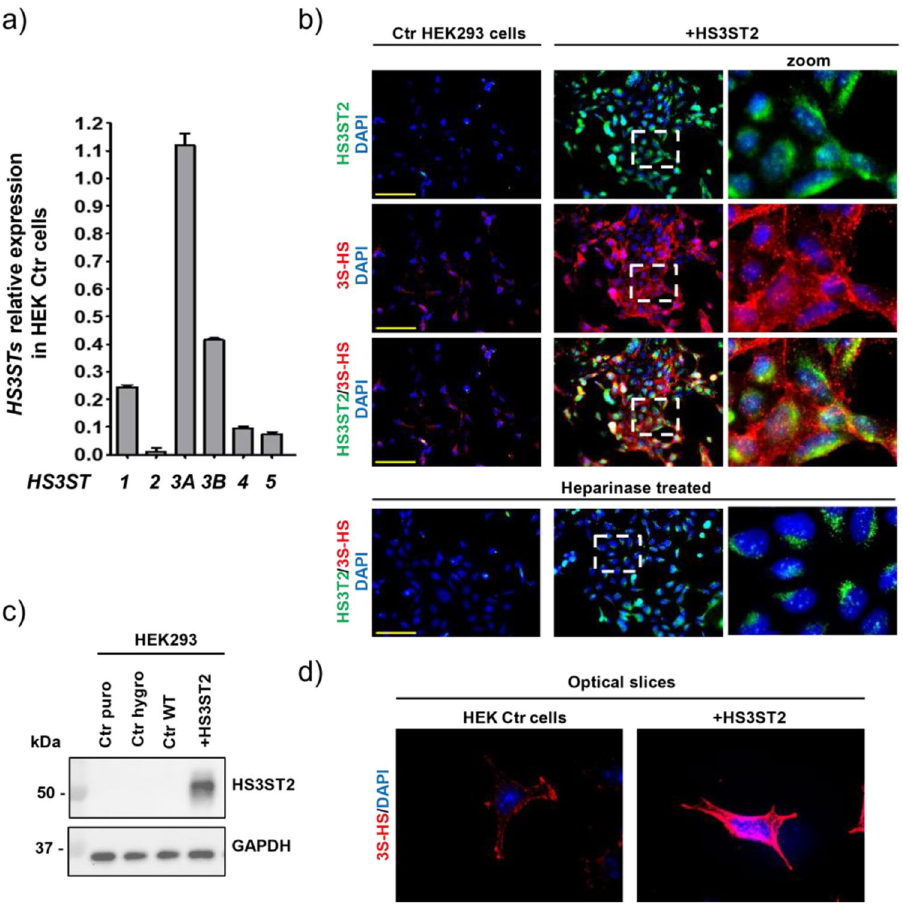
Figure 1. HEK293 expressing HS3ST2 cells produce 3S-HS. ( a ) Expression of different HS3STs in wild type (WT) HEK293 cells (HEK Ctr cells). Relative gene expression was normalized with B2M and RPL37A. Mean values ± SD ( n = 3) are represented. ( b ) HS3ST2 and 3- O -sulfated HS (3S-HS) immunostaing in HEK Ctr cells and in HS3ST2 expressing cells (HEK+HS3ST2). The newly expressed HS3ST2 was enzymatically active, as shown by 3S-HS immunolabelling with the HS4C3 antibody loss of signal after heparitinase treatment (lower panel) in ( b ). Cells were counterstained with DAPI to visualize nuclei (blue). Images were acquired by a IX81 Olympus microscope (magnification 20x), scale bar is 100 µm. ( c ) HS3ST2 protein immunoblotting using GAPDH as loading control (RIPA cell lysates). ( d ) 3S-HS immunocytochemistry using the HS4C3 antibody shows staining predominantly at the cell membrane. Confocal slice images were acquired by a confocal microscope IX81 Olympus (magnification 60×, immersion